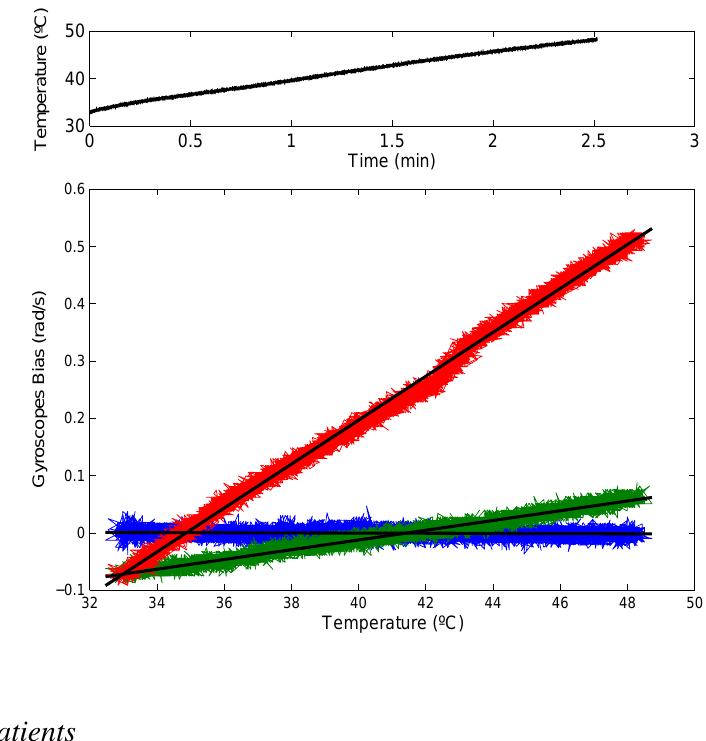
Figure 2 . Relationship between gyroscope offset and temperature. Top plot shows tem- perature variation measured by the IMU. Bottom plot shows correlation between offset and temperature for X (blue), Y (green) and Z (red) axis gyroscopes. High correlation is observed.